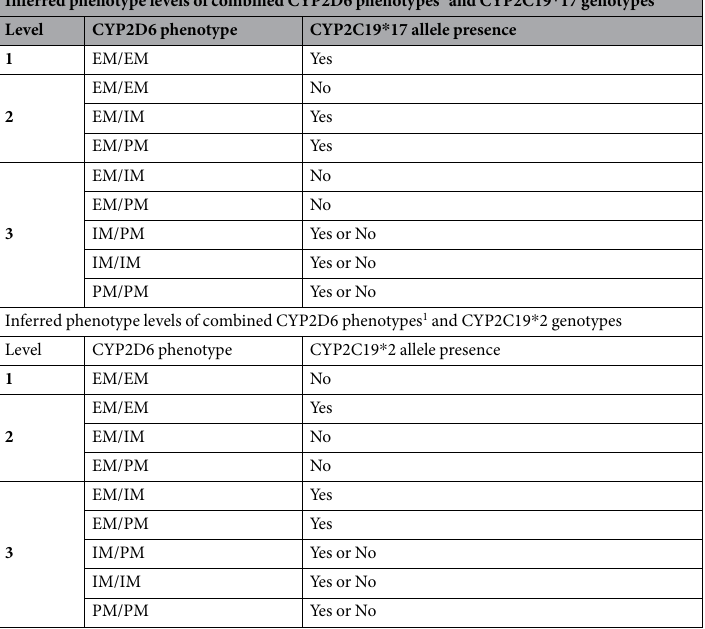
CYP2D6 phenotype/CYP2C19 genotype combinations.